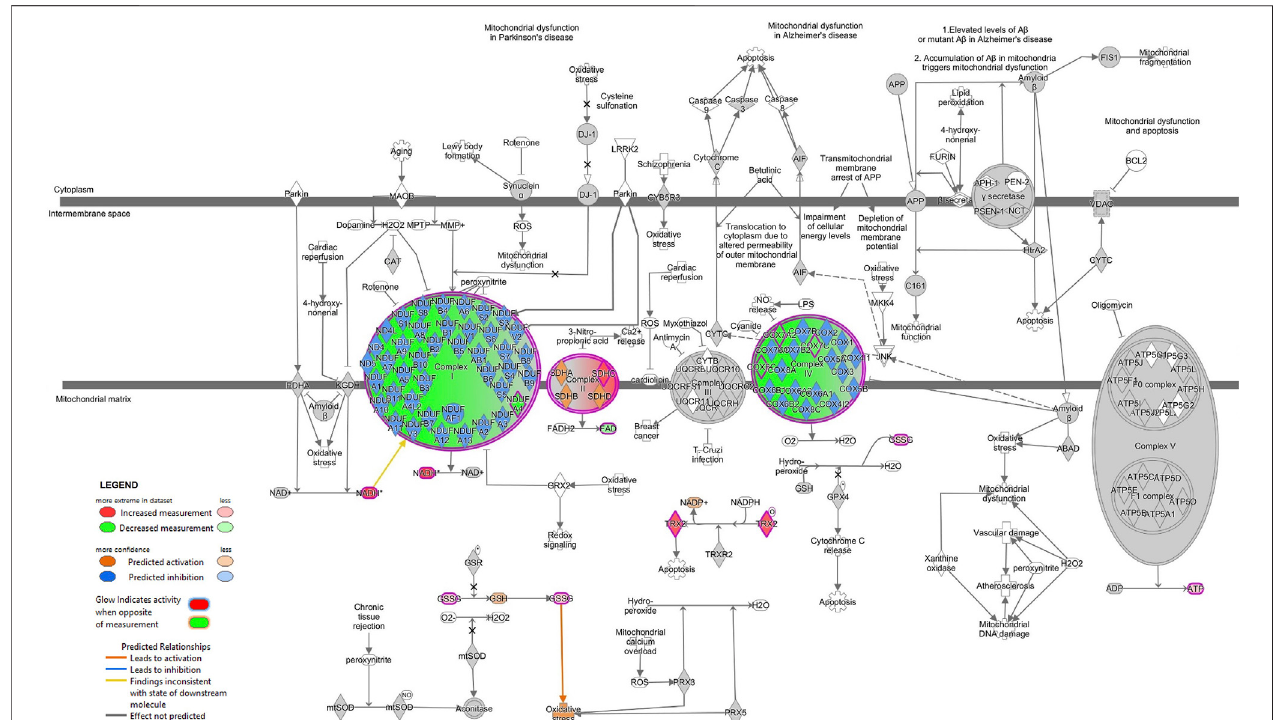
FIGURE8| Mitochondrialdysfunctionispredicted inSH-SY5YMitoPPXcells(meta-analysis).Predictedup-anddownstreampathways ofmoleculesparticipating inmitochondrialfunctionwereperformedusingthe ‘ MAP ’ optioninIPAsoftware.ThedecreaseofsomeofthesubunitsofETCcomplexIandIVtogetherwithanincrease of some of the subunits of ETC complex II lead to an unbalanced functioning of OXPHOS. The prediction states an increase in the glutathione (GSH) and NADP + levels (due to increase in GSSG and TRX2, respectively), probably as an attempt to counteract the potential oxidative stress consequence of a potential mitochondrial dysfunction.